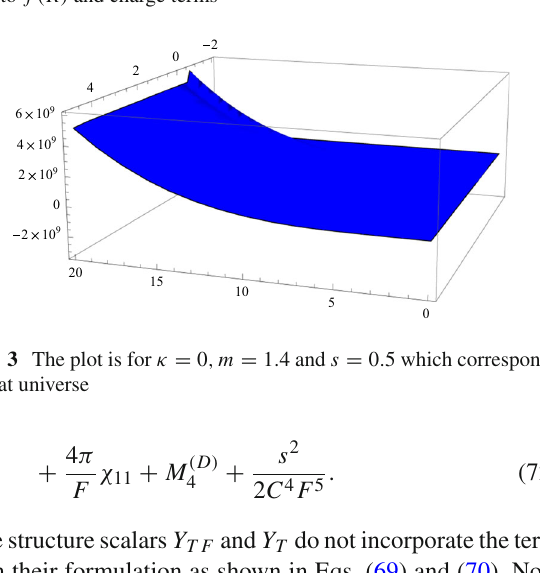
Fig. 2 The plot is for κ > 0 , m = 1 . 4 and s = 0 . 5 which corresponds to open universe that expands exponentially and expansion increases due to f ( R ) and charge terms